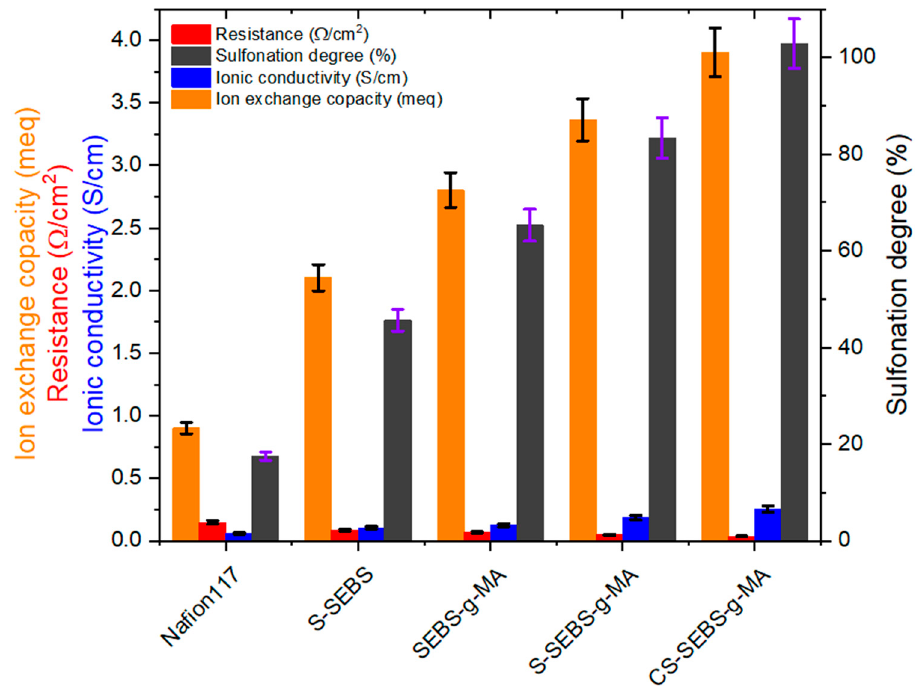
Figure 6. Degree of sulfonation, ionic conductivity and IEC of the different membranes studied in this work.